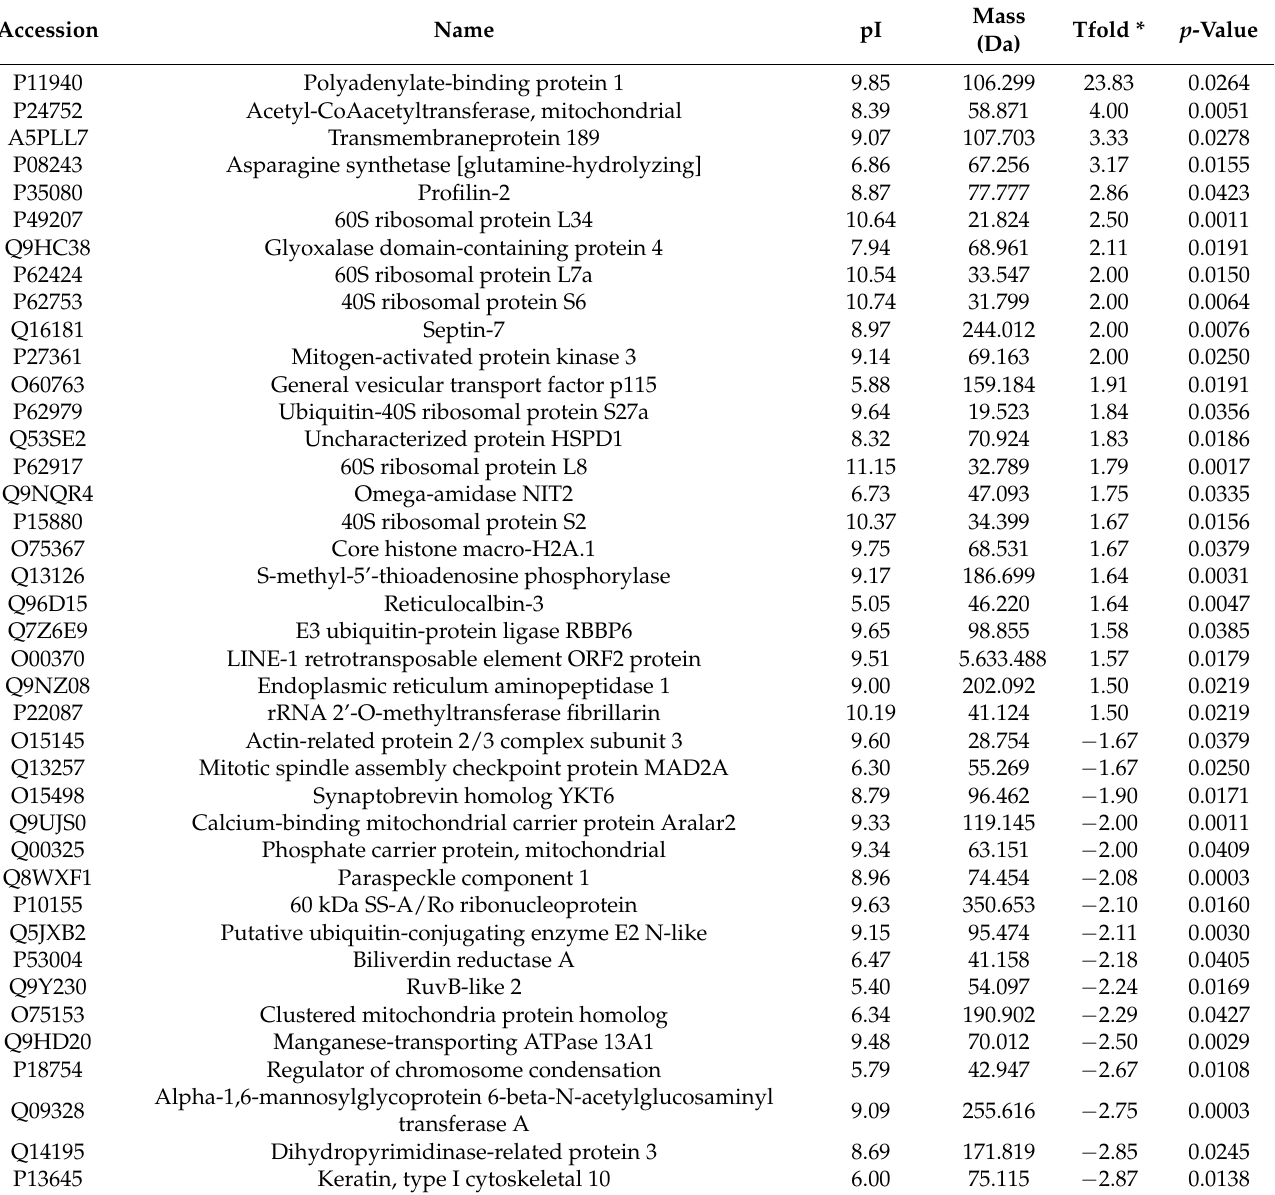
Table 1. List of 40 modulated proteins (24 up-regulated and 16 down-regulated) in the conditioned medium of low-dose irradiated chondrosarcoma cells, as compared with non-irradiated chondrosarcoma